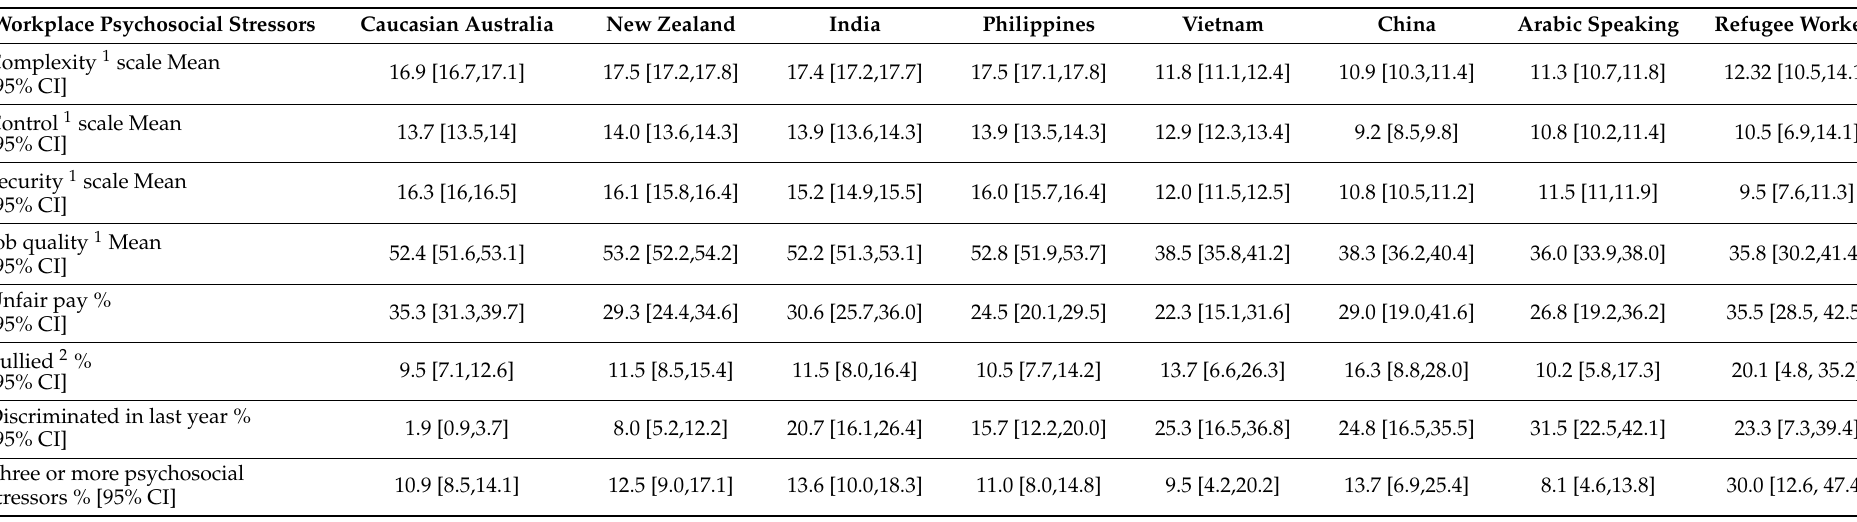
Table 3. Estimates (expressed as means or percentages with 95% CI) for workplace psychosocial stressors for Caucasian Australian a and migrants workers from six countries a and refugee workers b